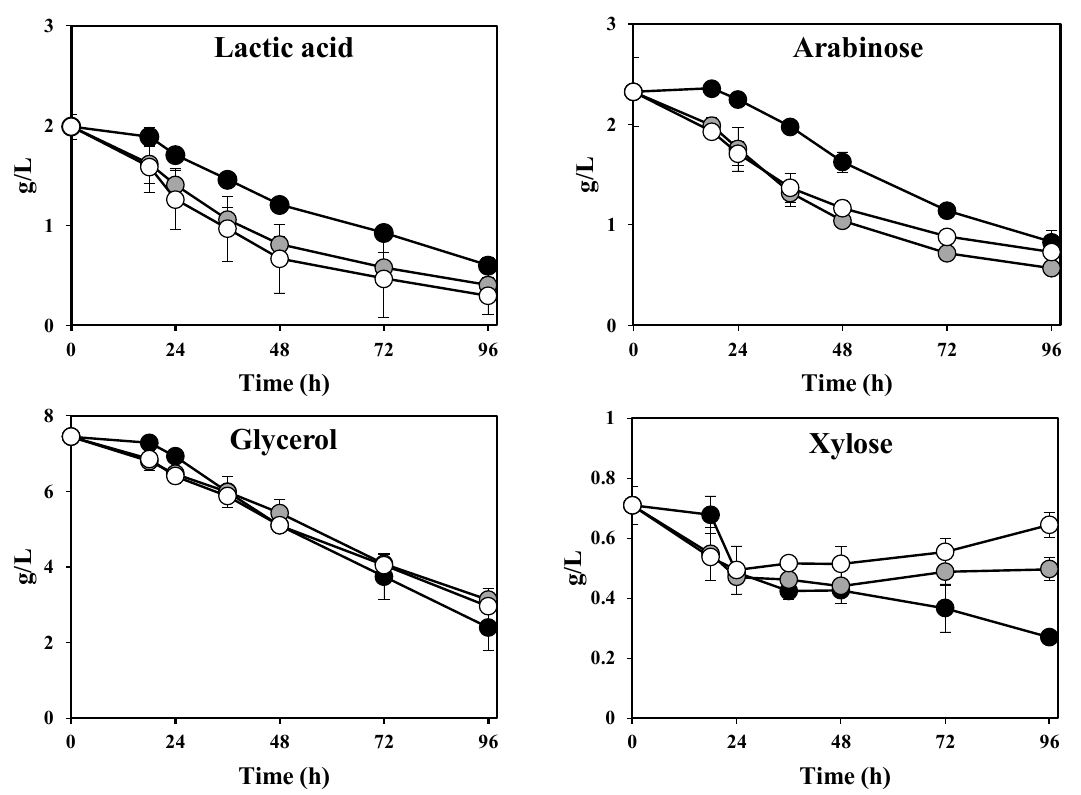
Figure 3. Concentration of lactic acid, glycerol, ethanol, arabinose and xylose